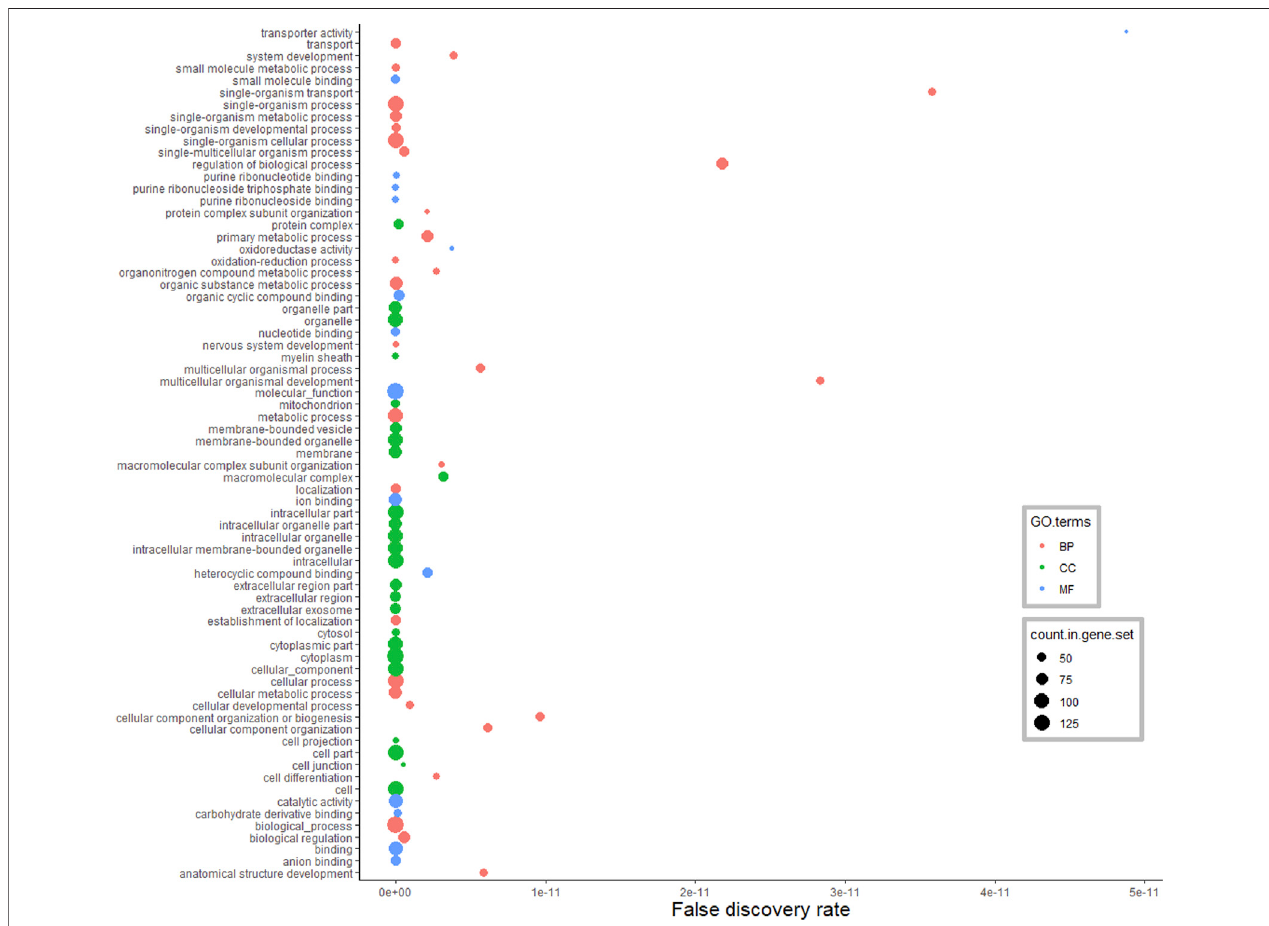
FIGURE 3 | Functional classi fi cation of differentially abundant proteins in the hypothalamus between pre-versus postpubertal heifers. Only highly signi fi cant GO terms were shown (FDR < 1.0E − 10).